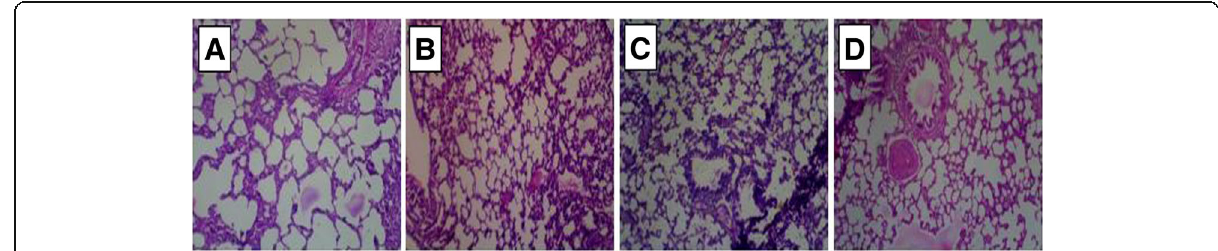
Fig. 9 Histopathological analysis of lung tissue in various concentration. a : Control group, b : Low dose (300 mg/kg), c : Mild dose (600 mg/kg), d : High dose (1200 mg/kg)